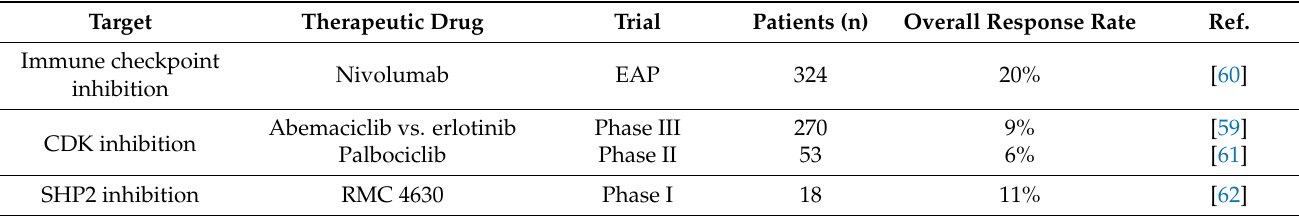
Table 3. Indirect KRAS inhibition—Immune checkpoint, CDK4/6 and SHP2 inhibition.